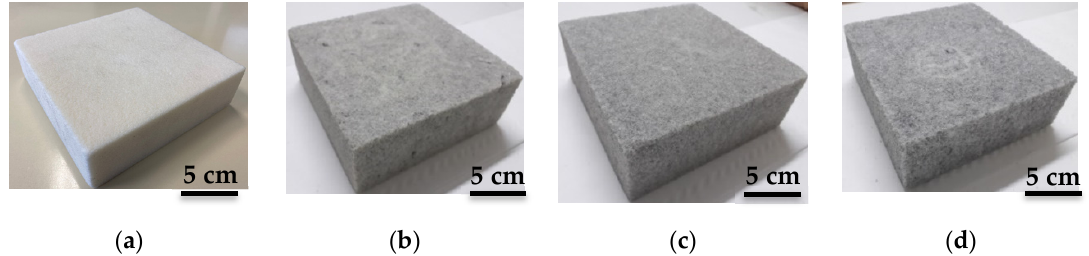
Figure 4. Photos of ( a ) unloaded epoxy foam and samples loaded with 0.5 wt.% of 3 mm-CFs made with ( b ) spatula dispersion, ( c ) shear mixing, and ( d ) ultrasounds. Mixing duration is 5 min.